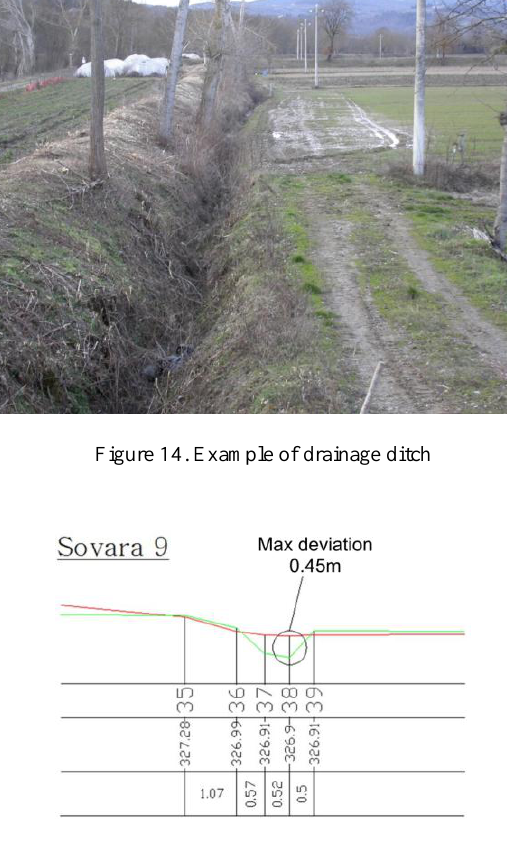
Figure 15. Example of drainage ditch not represented in the DTM – Topographic survey in green, last pulse DSM interpolated surface in